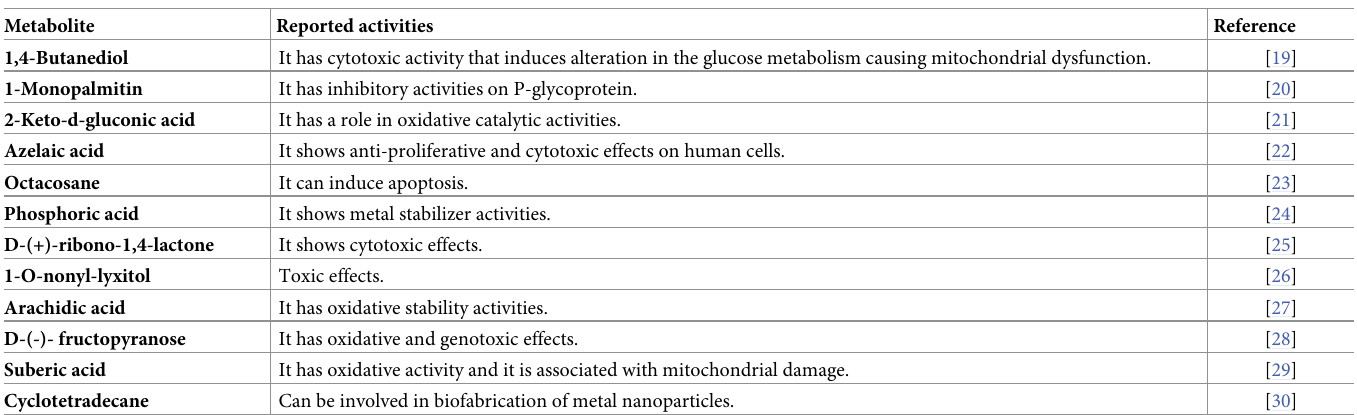
Table 2. Reported activities of major distinctive